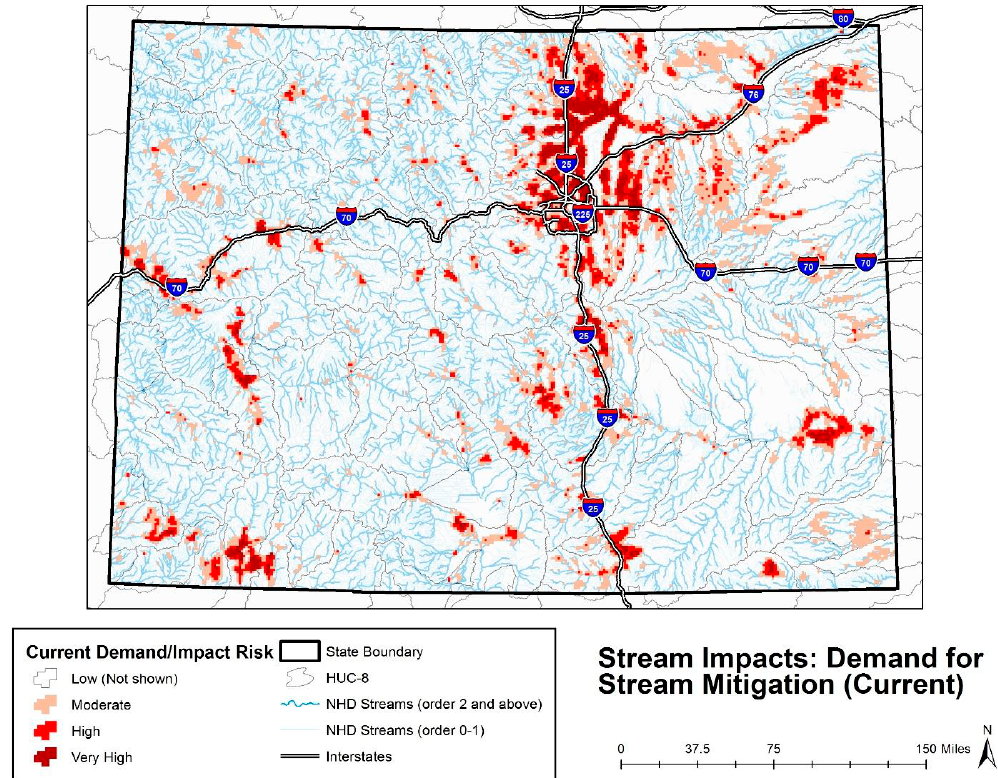
Figure 5. Current stream impacts/demand for mitigation in Colorado.